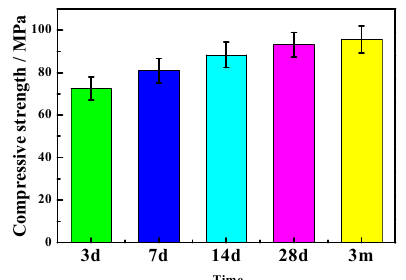
Figure 16. Compressive strength of the MOC samples cured naturally for different time in an indoor environment.